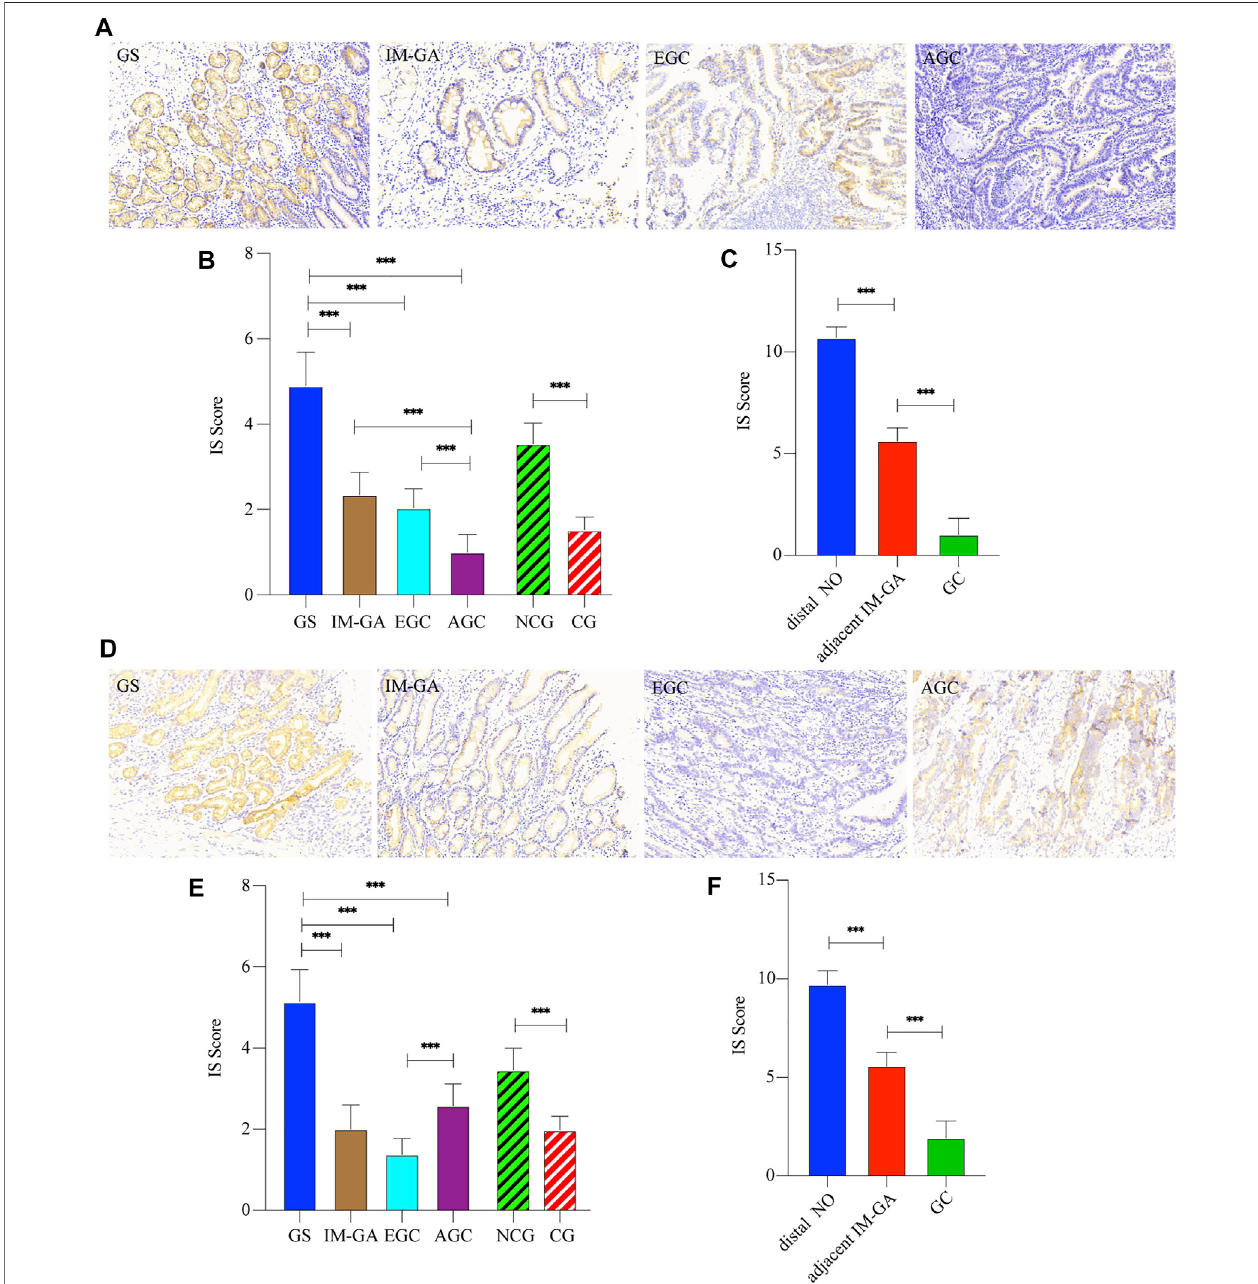
FIGURE 1 | The protein expressions of TRIB3 (A – C) and FABP1 (D – F) in different gastric tissues as well as in AGC and non-tumor adjacent tissue. Magni fi cation × 200.